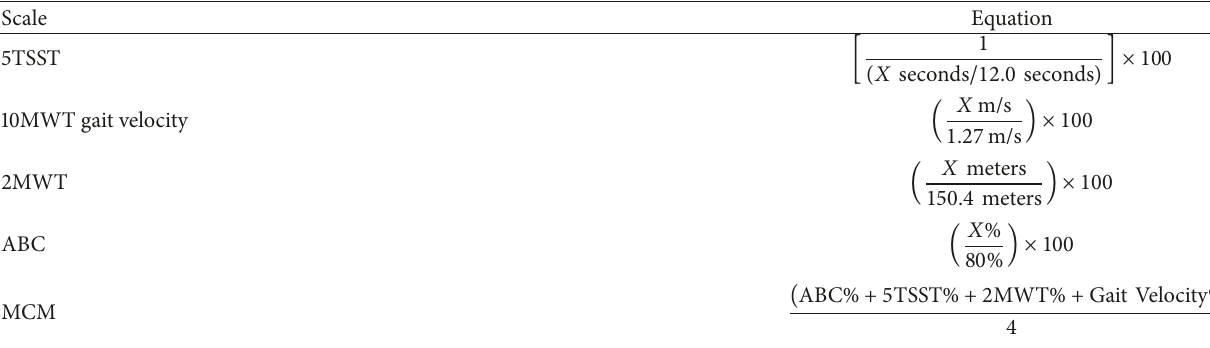
Table 2: Conversion of equations to percentage.